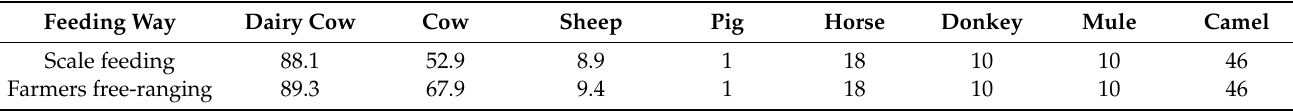
Table 3. Methane emission factor from intestinal fermentation of livestock and